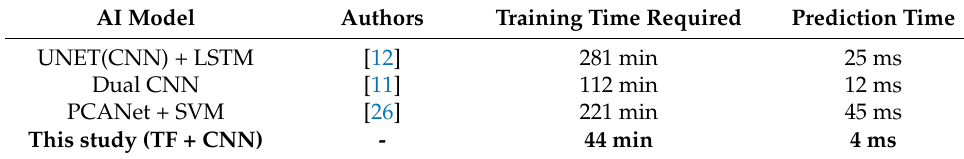
Table 2. Algorithmic Cost-Efficiency Comparison. AI Model Authors Training Time